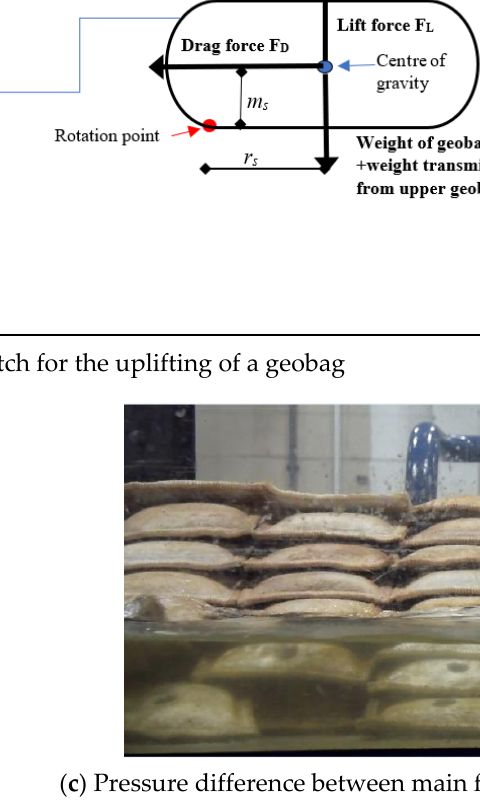
Figure 5. Failure due to uplifting.